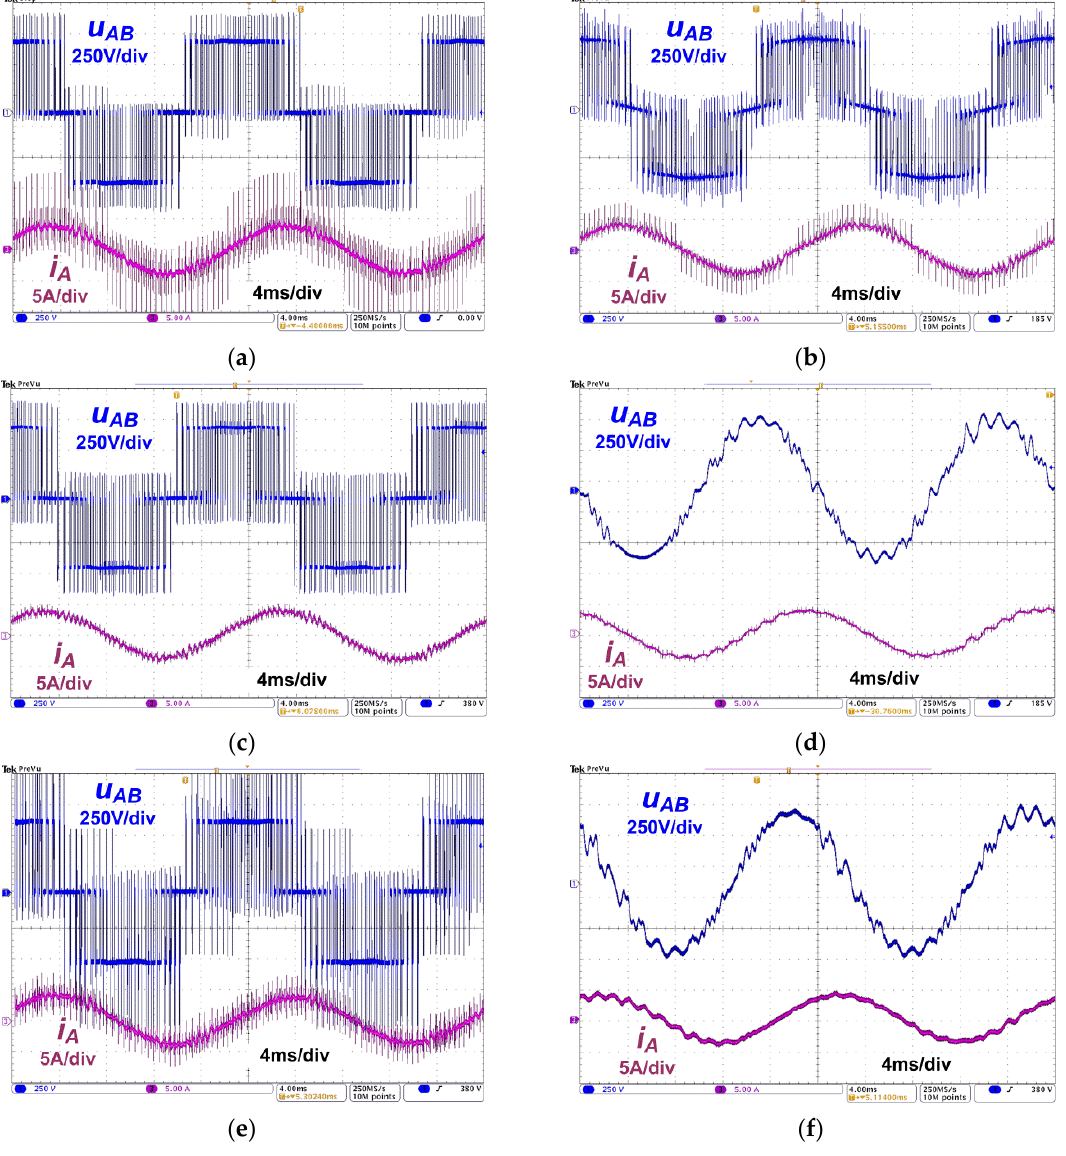
Figure 22. Experimental waveforms of line-to-line voltage u AB and current i A measured at motor terminals in a configuration with a 1 m cable for: ( a ) inverter; ( b ) motor choke; ( c ) du/dt choke; ( d ) sine-wave filter; ( e ) CM choke; ( f ) CM choke with sine-wave filter.